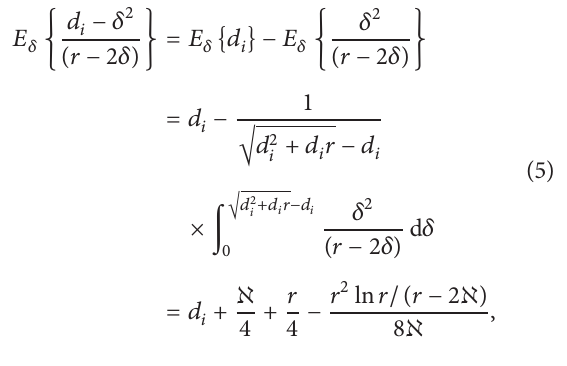
Figure 1: Deployment of RPs in linear calibration